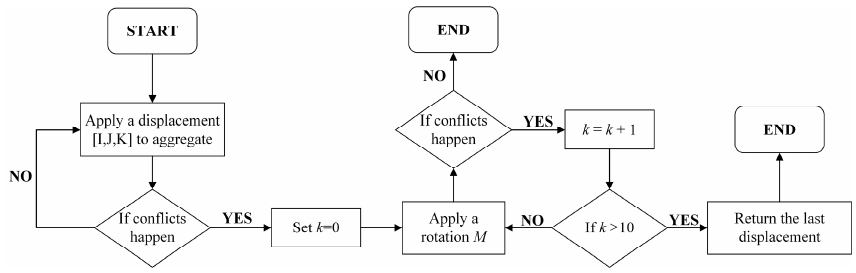
Figure 4. The fl owchart of the moving-and-densifying algorithm. Figure 4. The flowchart of the moving-and-densifying